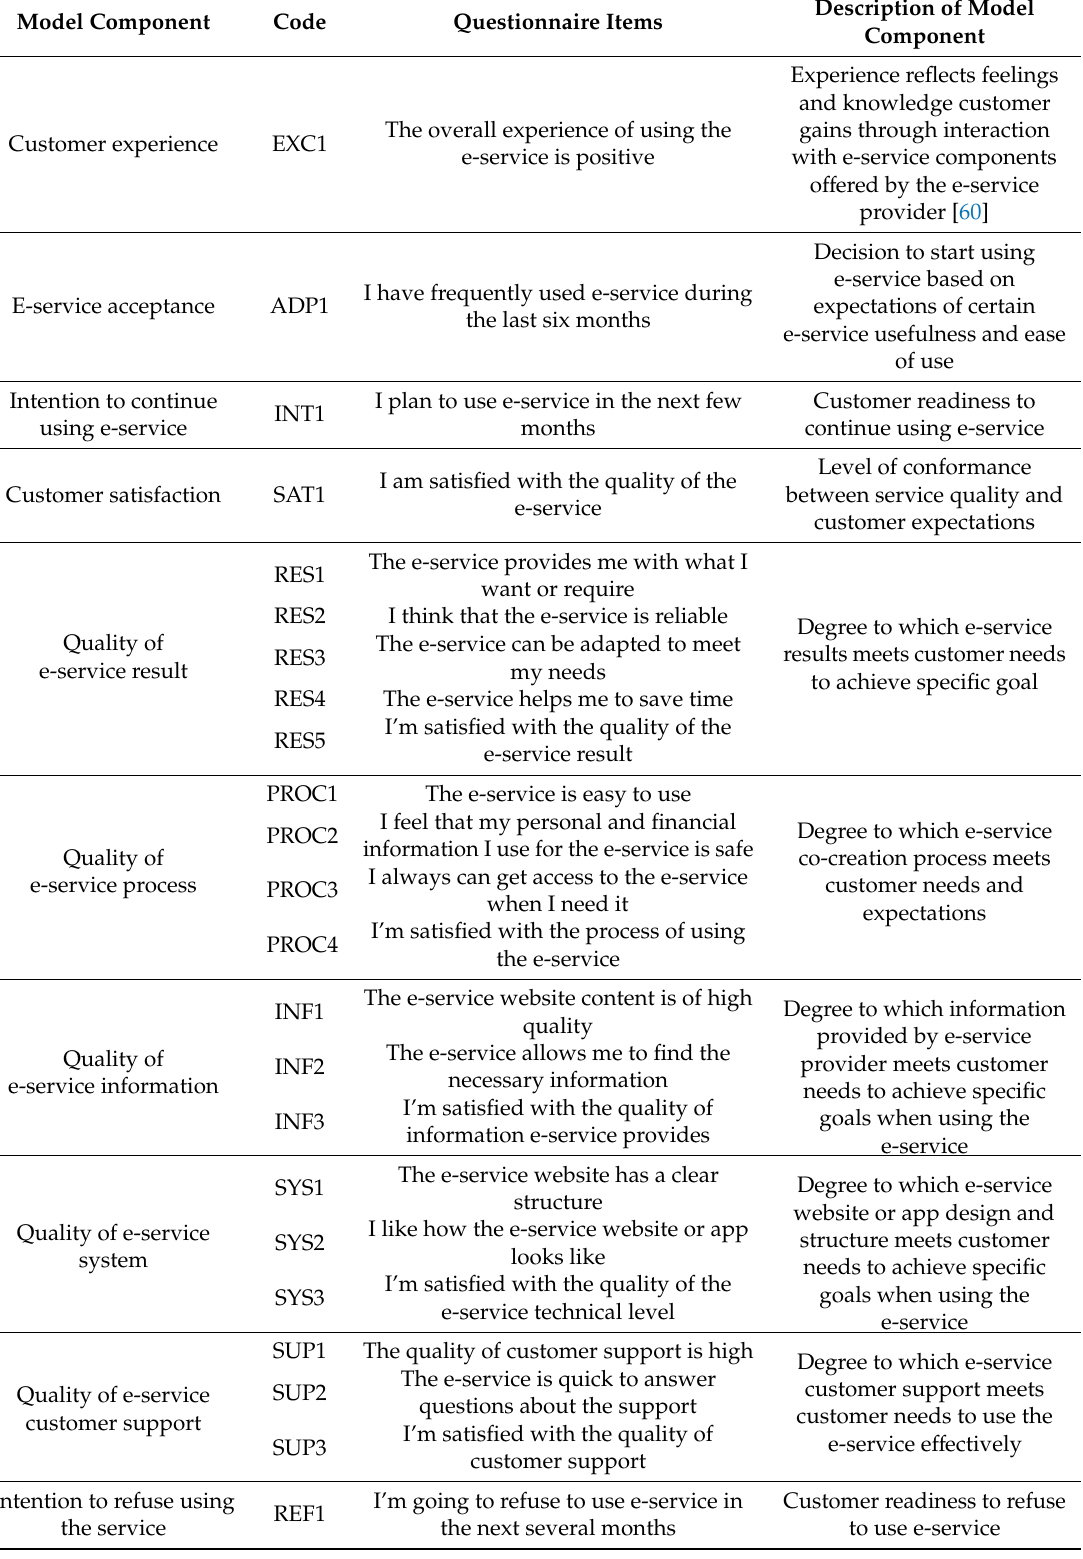
Table 2. Correspondence between questionnaire items and model